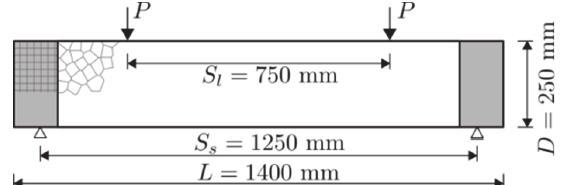
Figure 2: Dimensions of the simulated beam loaded in four-point bending.